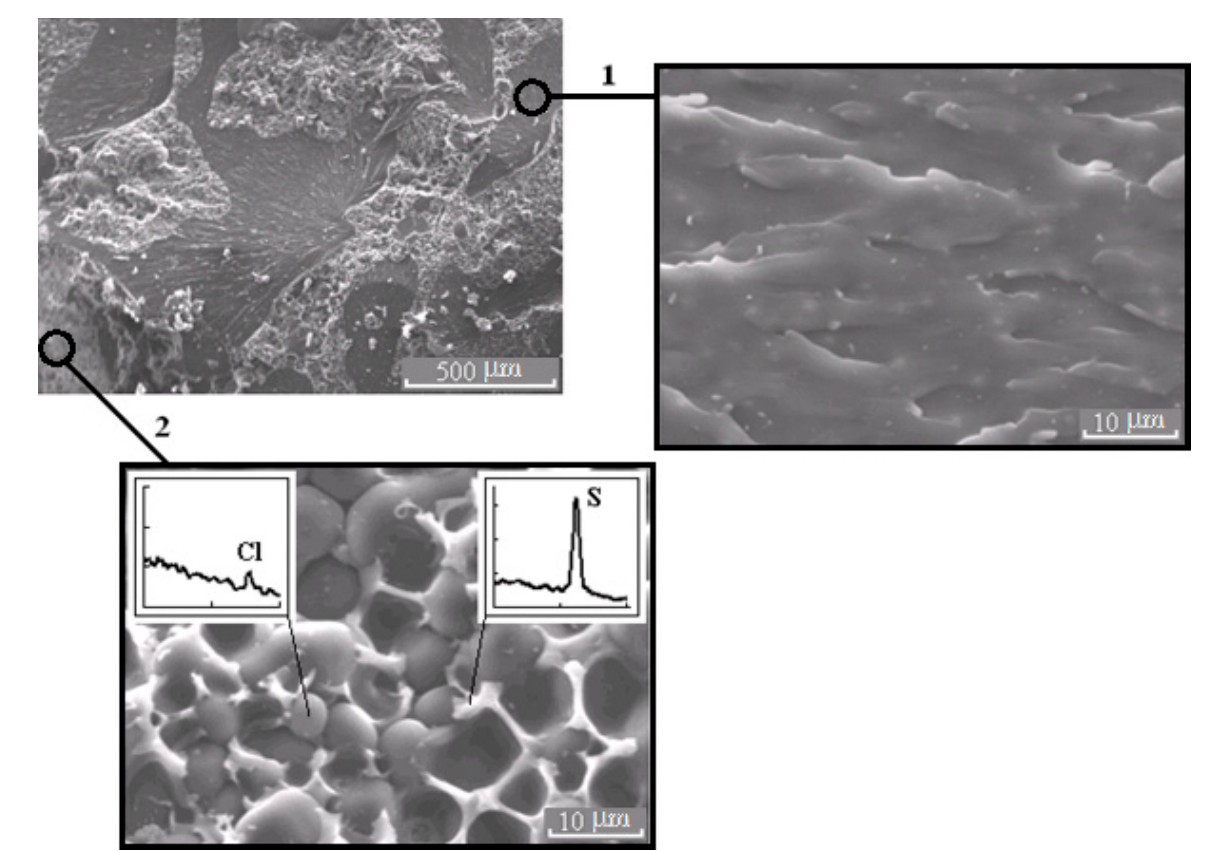
Figure 6. Morphology of the mixture PSU–EO at φ PSU 10 wt.% with bicontinuous type of structure; 1 and 2 are regions enriched in epoxy polymer and TP, respectively. On the inserts, fragments of the X-ray spectra of microphases are represented.